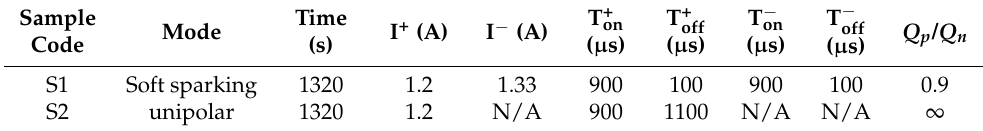
Table 2. PEO process parameters for Ti6Al4V alloy with CS-coating.